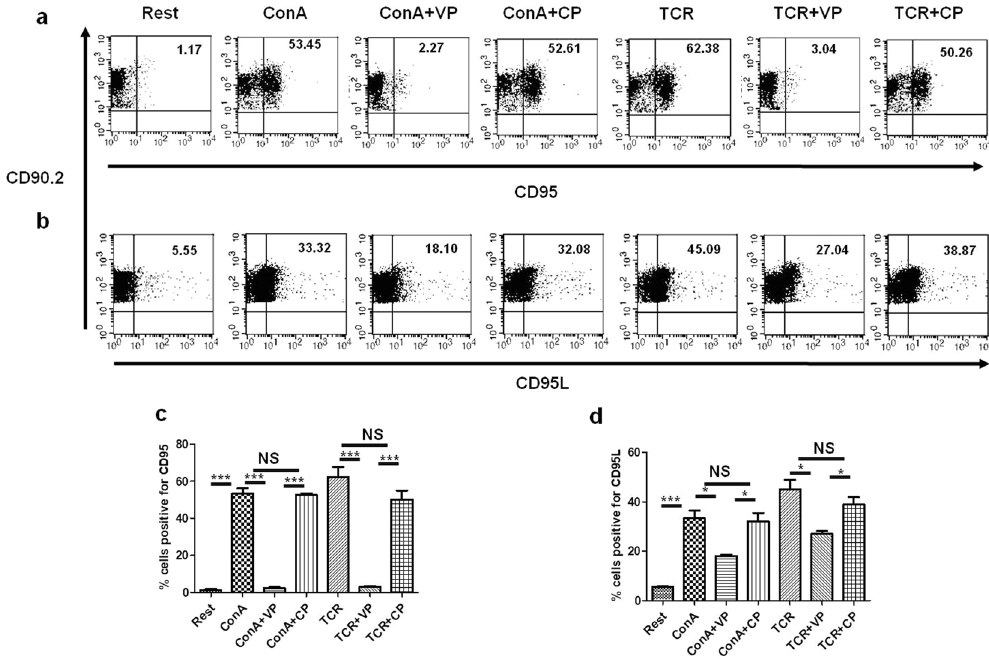
Figure 6. VIPER regulates induction of Fas (CD95) and FasL (CD95L) during T cell activation. Flow cytometric dot plot showing expression of CD95 ( a ) and CD95L ( b ) in T cells treated with VIPER and CP followed by ConA and TCR mediated activation. VIPER treated cells showed significantly reduced expression (% positive cells) of CD95 and CD95L as compared to cells treated with only ConA /TCR. Bar diagram showing % cells expressing ( c ) CD95 and ( d ) CD95L from three independent similar experiments. Data shown are representative of three independent experiments and Bars represent the mean ± SEM. * p < 0.05, ** p < 0.01, *** p <